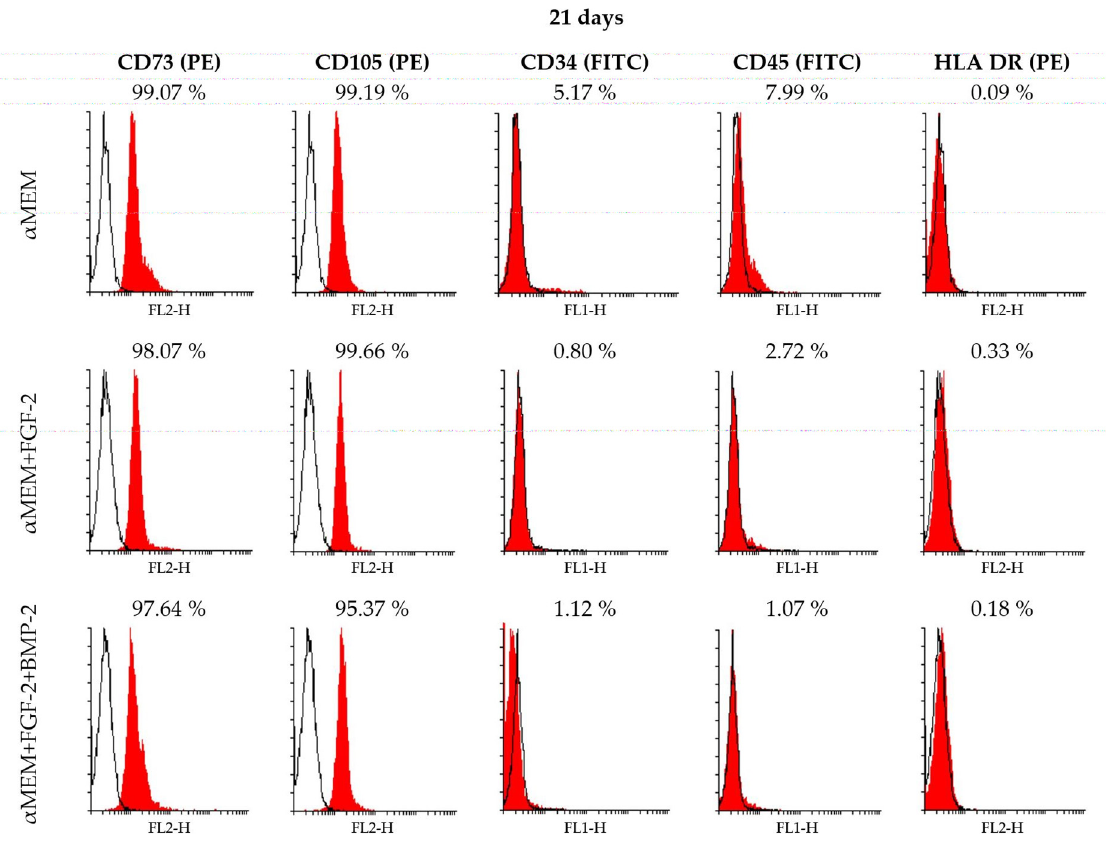
Figure 3. Flow cytometry analysis of BM-MSCs cultured in the control medium α MEM and in a medium supplemented with BMP-2 and/or FGF-2 for 21 days. The expression of the MSC-specific antigens CD73 and CD105 was detected for all cells cultured in different conditions. Cells expressing the hematopoietic markers CD34, CD45, and HLA DR were absent or detected at low levels on day 21 of observation in all culture conditions.